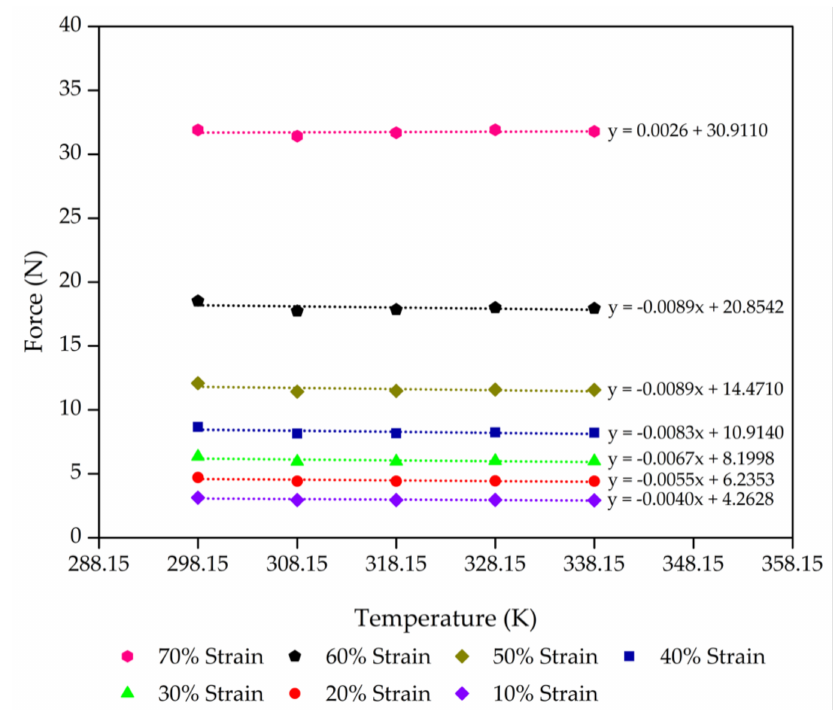
Figure 7. Compression force as a function of the temperature of the control - 45% Po sample from 10% to 70% compression strain with a minimum linear regression (R 2 ) = 0.9 at each strain. The scatter on the results is on the order of the size of the data